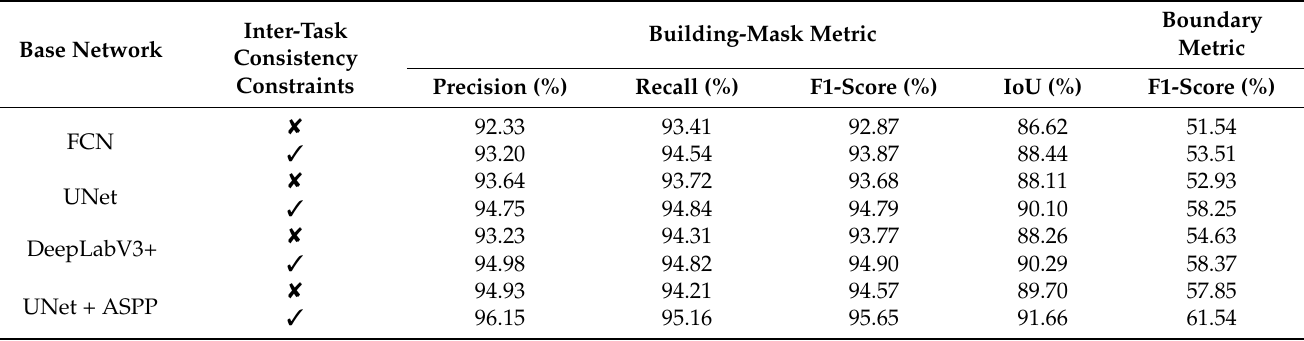
Table 5. Comparison of different base networks with or without the inter-task consistency constraints.